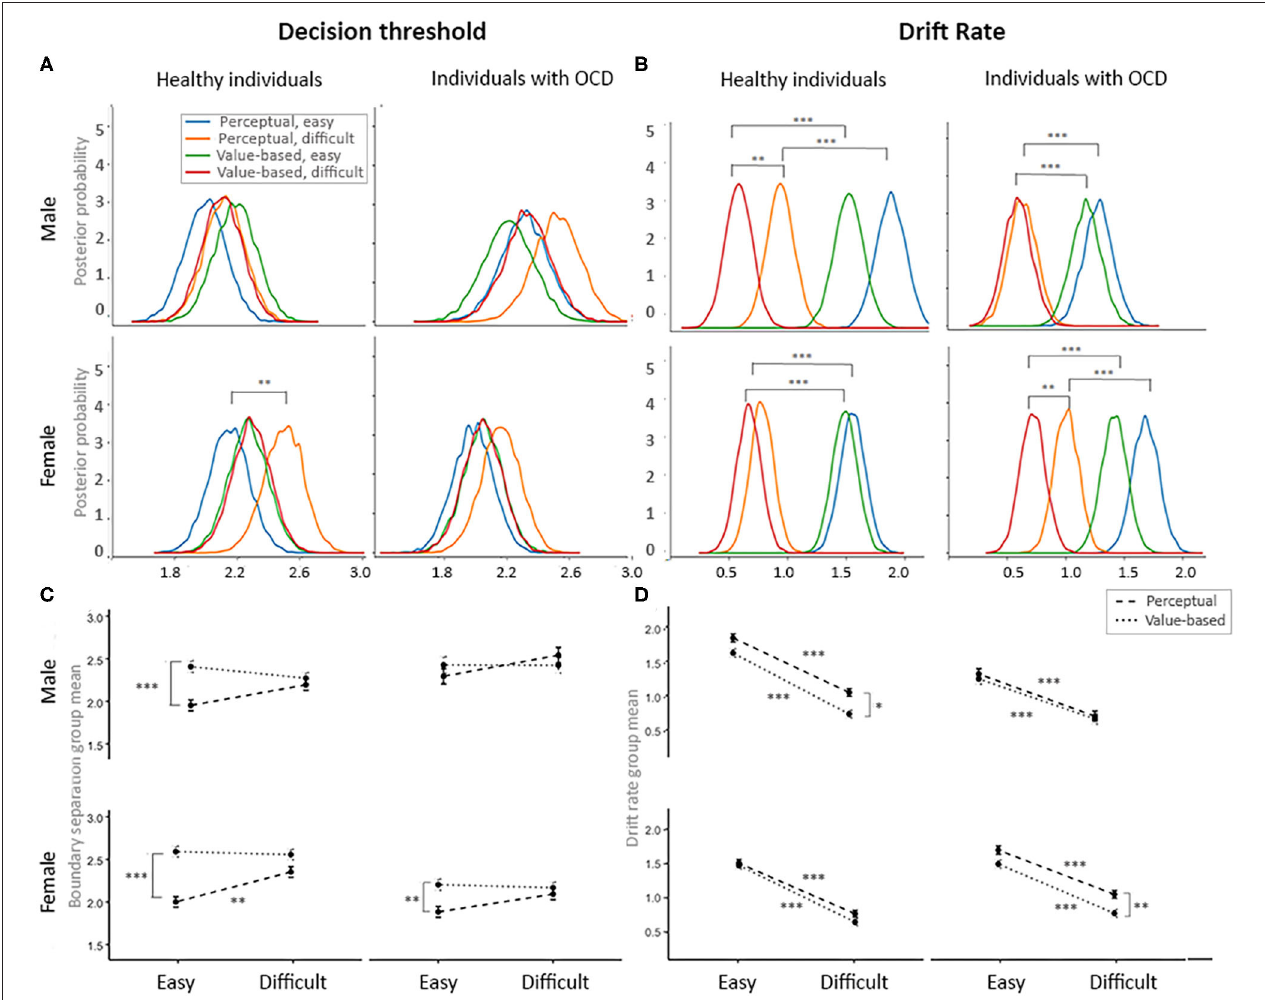
FIGURE 4 | Flexible adjustment to the task demands by diagnostic and gender groups. (A) Posterior probability plots of the decision threshold for each of four groups of interest across four decision contexts. (B) Posterior probability plots for the drift rates for each of four groups of interest across four decision contexts. (C) Mean plots for the decision thresholds for each of four groups of interest across four decision contexts. (D) Mean plots for the drift rates for each of four groups of interest across four decision contexts. Significance levels: * p = 0.10, ** p = 0.05, *** p = 0.01.